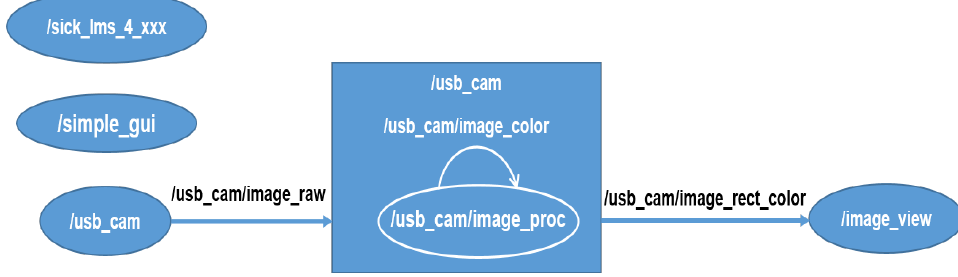
Figure 5. Diagram of the active ros nodes during 3D